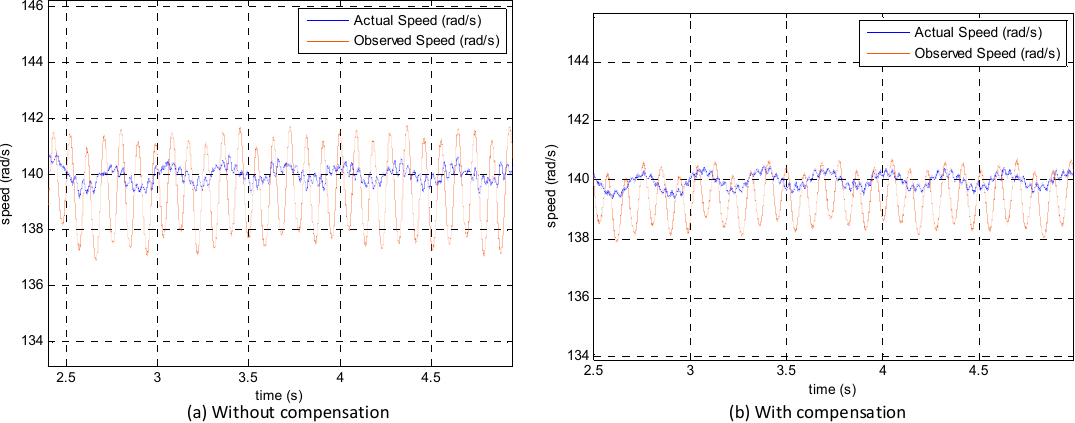
Figure 15. The experimental results of actual speed and observer speed at 140 rad/s.